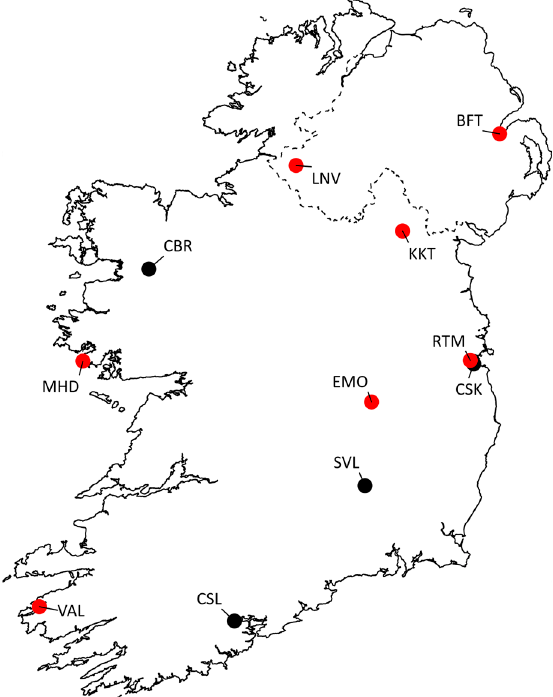
Figure 1. Ambient air quality monitoring stations ( n = 11) measuring tropospheric ozone that meet the minimum data threshold of five years (2015–2019), and the seven stations that meet the 15-year threshold (2005–2019; represented by red filled circles) on the island of Ireland (see Table 1 for station ID codes). The dashed line represents the border between Northern Ireland (UK) and Ireland.